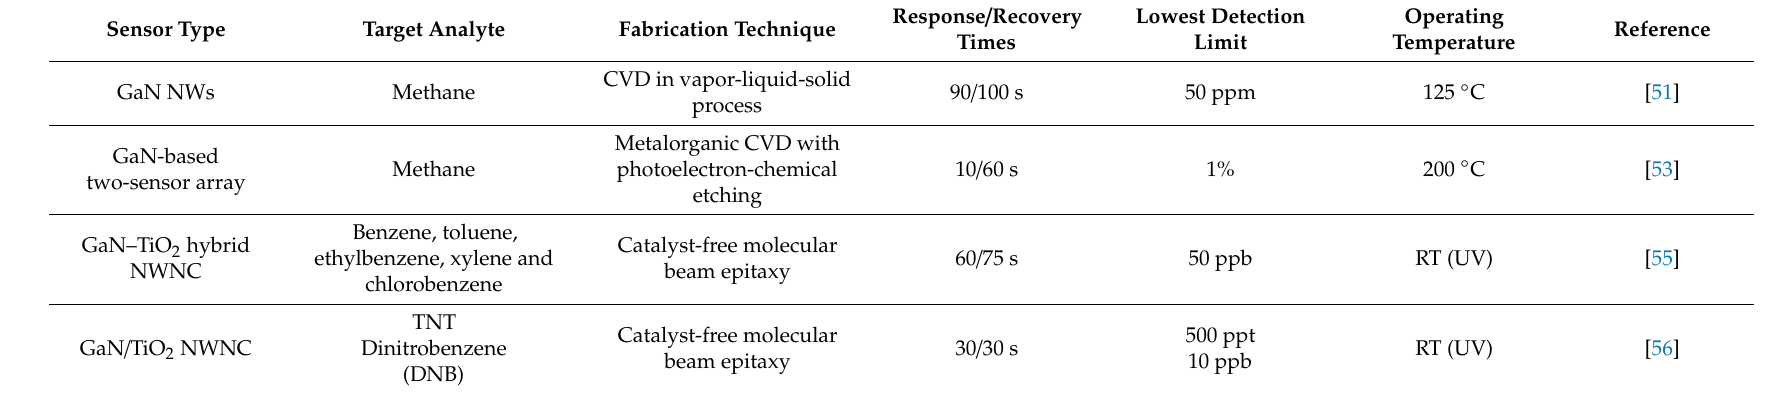
Table 3. Synthesis method and sensing properties of GaN nanostructures-based methane, benzene and its derivatives